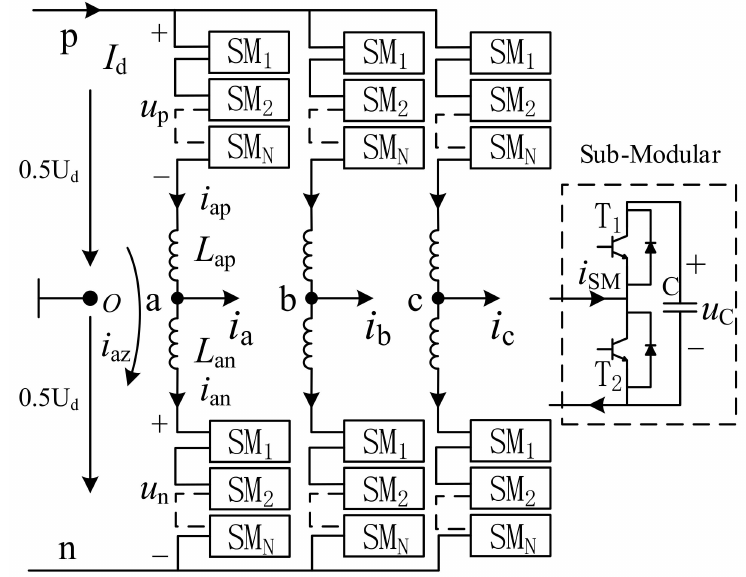
Figure 1. Modular multilevel converter (MMC) main circuit and its sub-modular